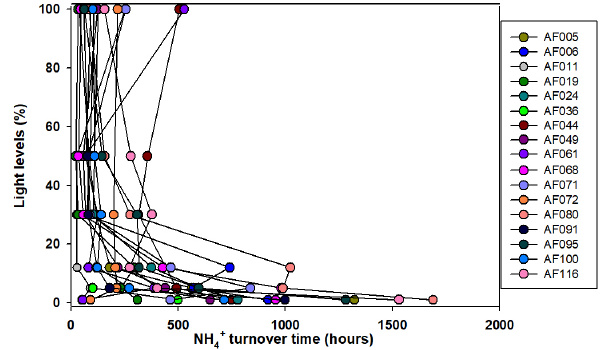
substrate, when small phy- 4